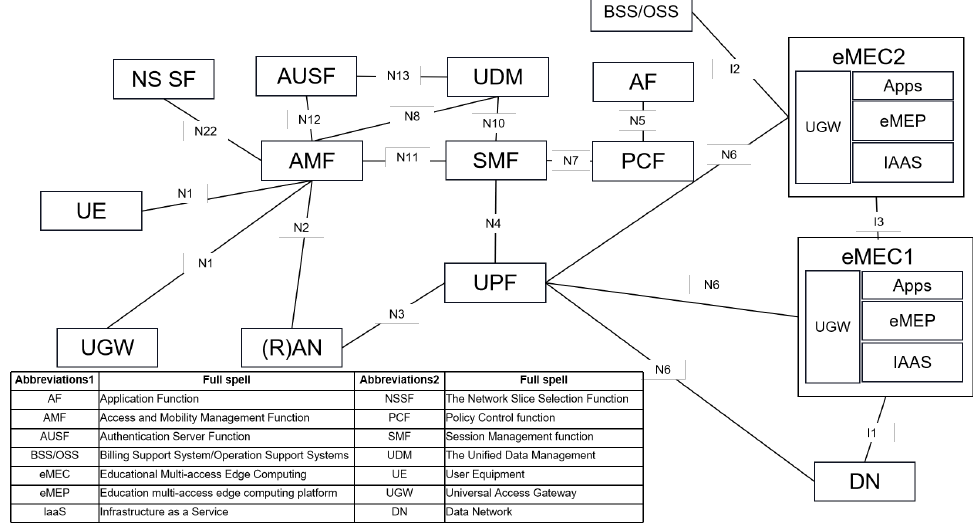
Figure 3. The architecture of a smart education-3GPP